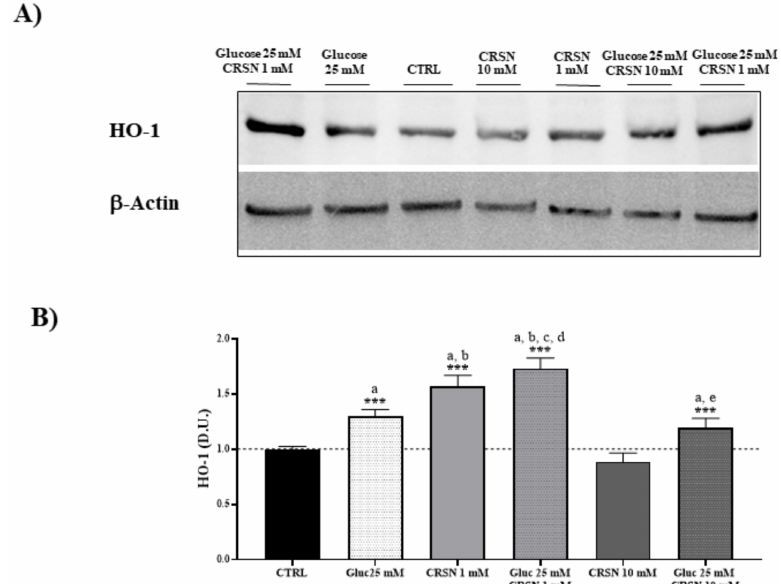
Figure 3. Cellular heme oxygenase-1 (HO-1) protein concentration (normalized to untreated cells) significantly increased in murine immortalized podocytes under glucose stress (25 mM; p = 5.4 × 10 − 6 ) or under carnosine addition (1 mM; p = 1.2 × 10 − 6 ). Co-incubation with carnosine (1 mM) and glucose (25 mM) induced further upregulation of HO-1 protein concentration compared to single treatment ( p = 1.2 × 10 − 6 vs. glucose and p = 0.03 vs. carnosine) or control ( p = 1.7 × 10 − 7 ), determined by western blotting ( A ) and quantified with an imaging software normalized to respective β -actin concentrations ( B ). Note: n = 5, a = significant increase vs. control; b = significant increase vs. glucose (25 mM), c = significant increase vs. carnosine (1 mM), d = significant increase vs. glucose (25 mM) + carnosine (10 mM), e = significant decrease vs. glucose (25 mM), *** p <